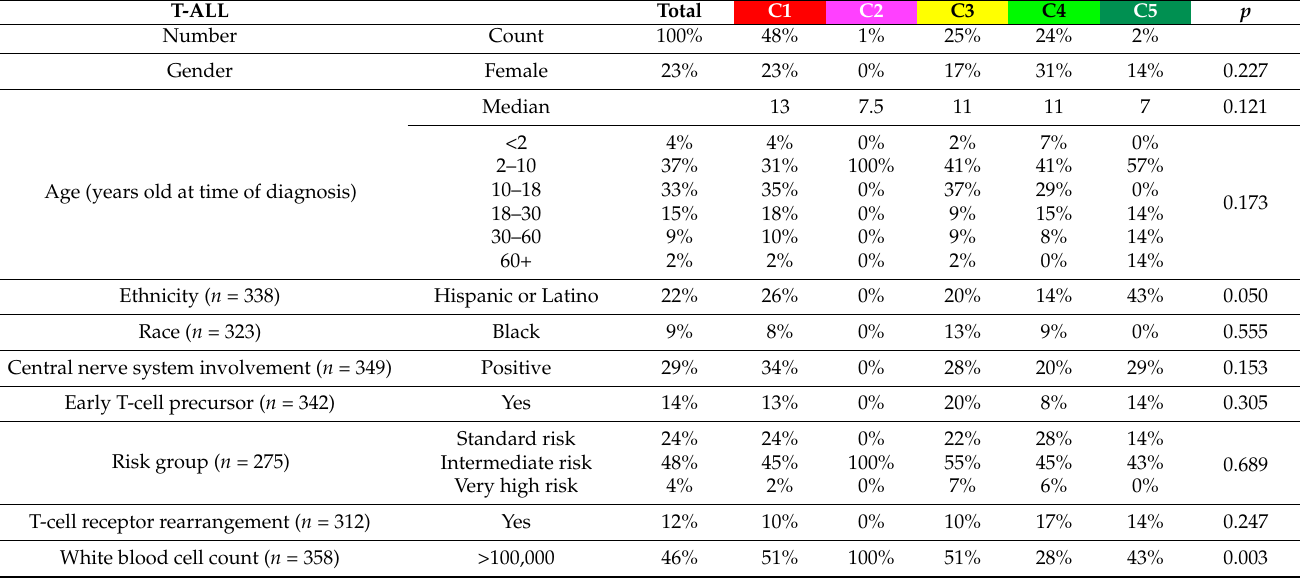
Table 3. Patient and disease characteristics across the five protein clusters in T-cell acute lymphoblastic leukemia